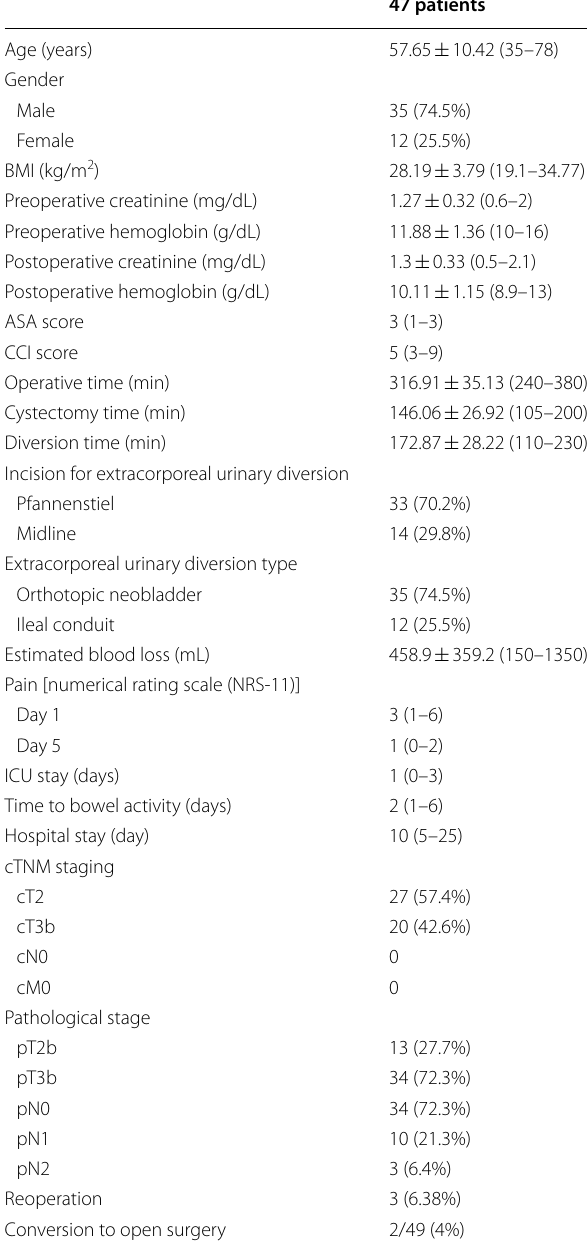
Table 1 Perioperative criteria and pathological